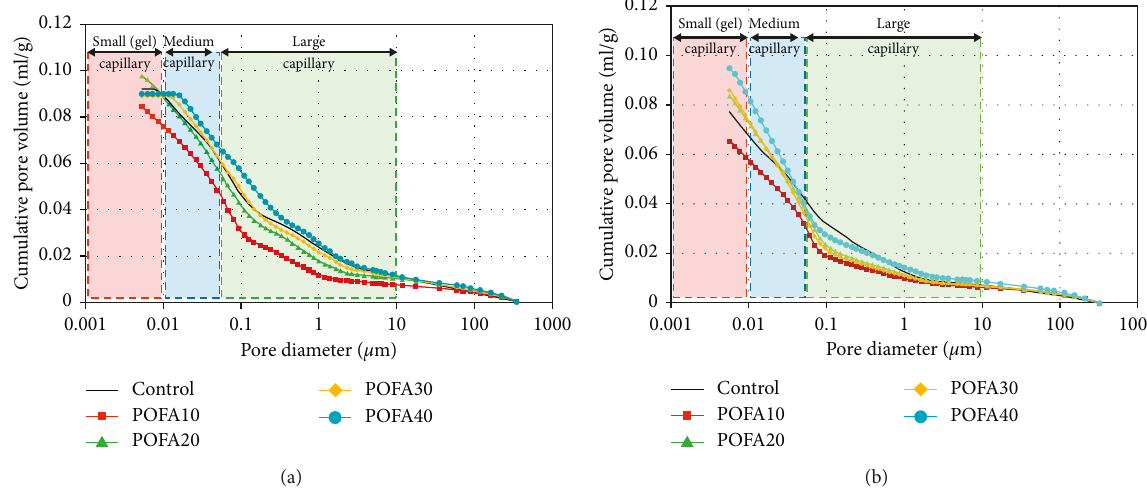
Figure 8: Cumulative pore volume of mortars containing mPOFA aged for (a) 3 and (b) 28 days.